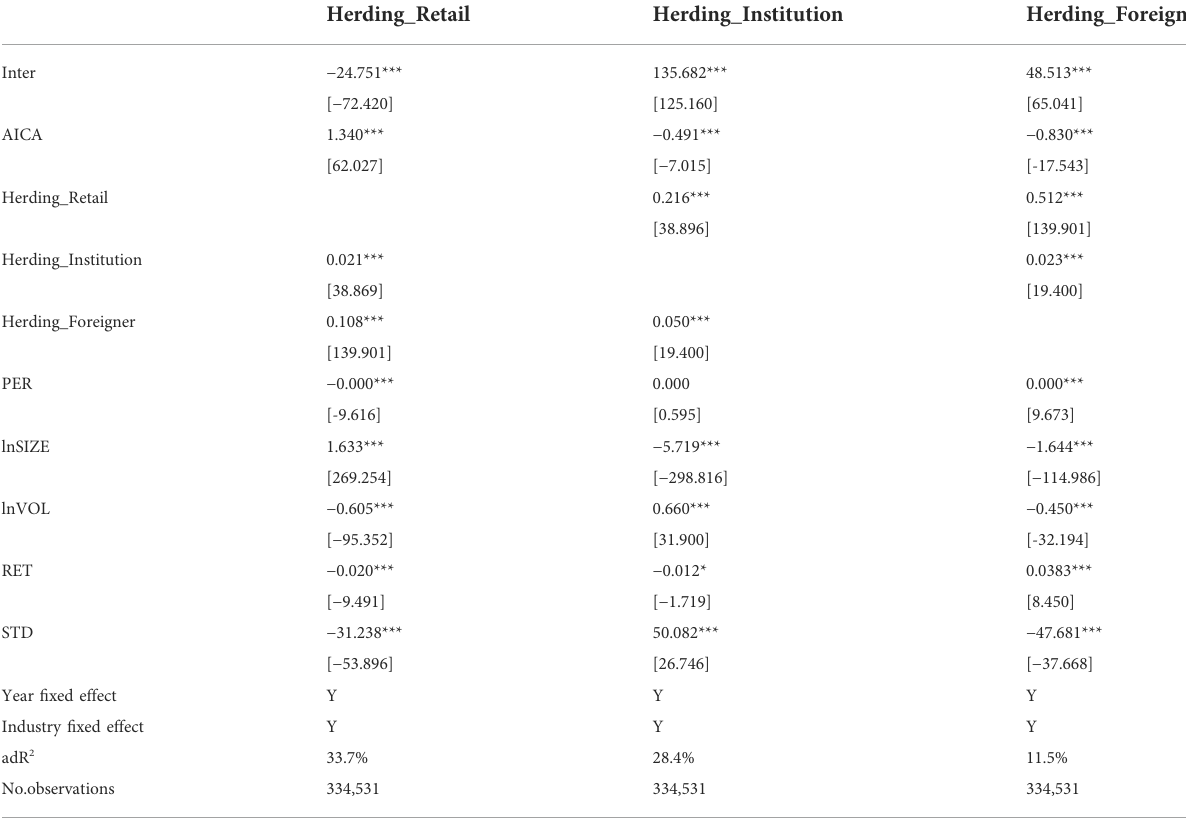
TABLE 2 Relationship between investor herding behavior and AICA. Table reports the impact of AICA on the retail, foreign and institutional investor herding measures. This table presents the parameter in Eq. 5. Herd_Retail, Herd_Foreigner and Herd_Institution are retail, foreign and institutionalherdingbehaviormeasures,respectively.AICAistheabnormalICA.lnSIZEisthevaluetakingthenaturallogofmarketcapitalization.PER is the P/E ratio. lnVOL is the value taking the natural log of the trading volume. STD is the standard deviation of daily returns from the previous 3